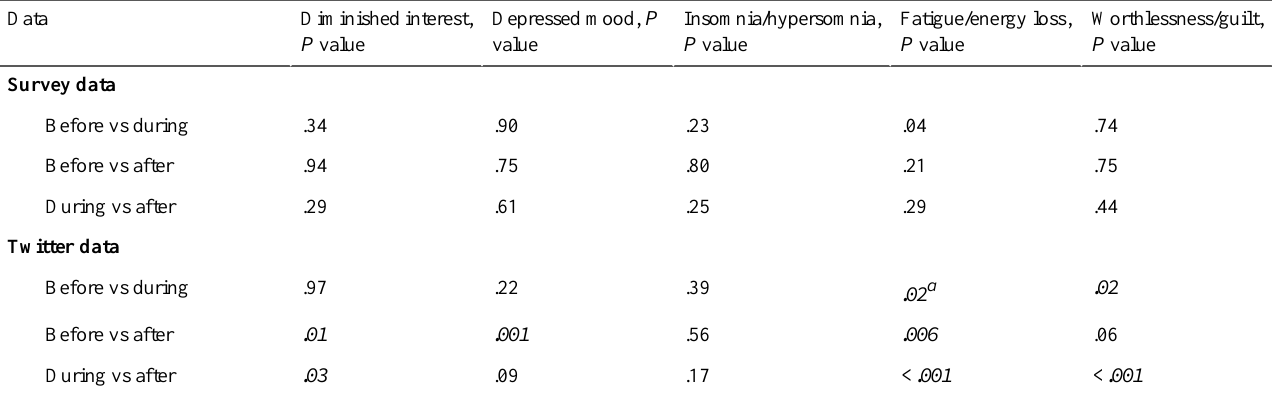
Table 2. P values indicating the significance of the comparisons before, during, and after the contact ban resulting from the Wald test.